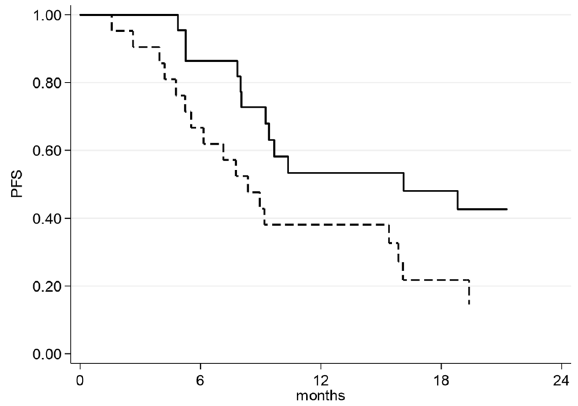
Figure 2. Progression-free Survival as a function of Total Abdominal Fat Index (TAFTI). Continuous line represents patients with normal (below the median value: 118.82 cm 2 /m 2 ) TAFTI, dashed line represents patients with high (equal or above the median value: 118.82 cm 2 /m 2 )